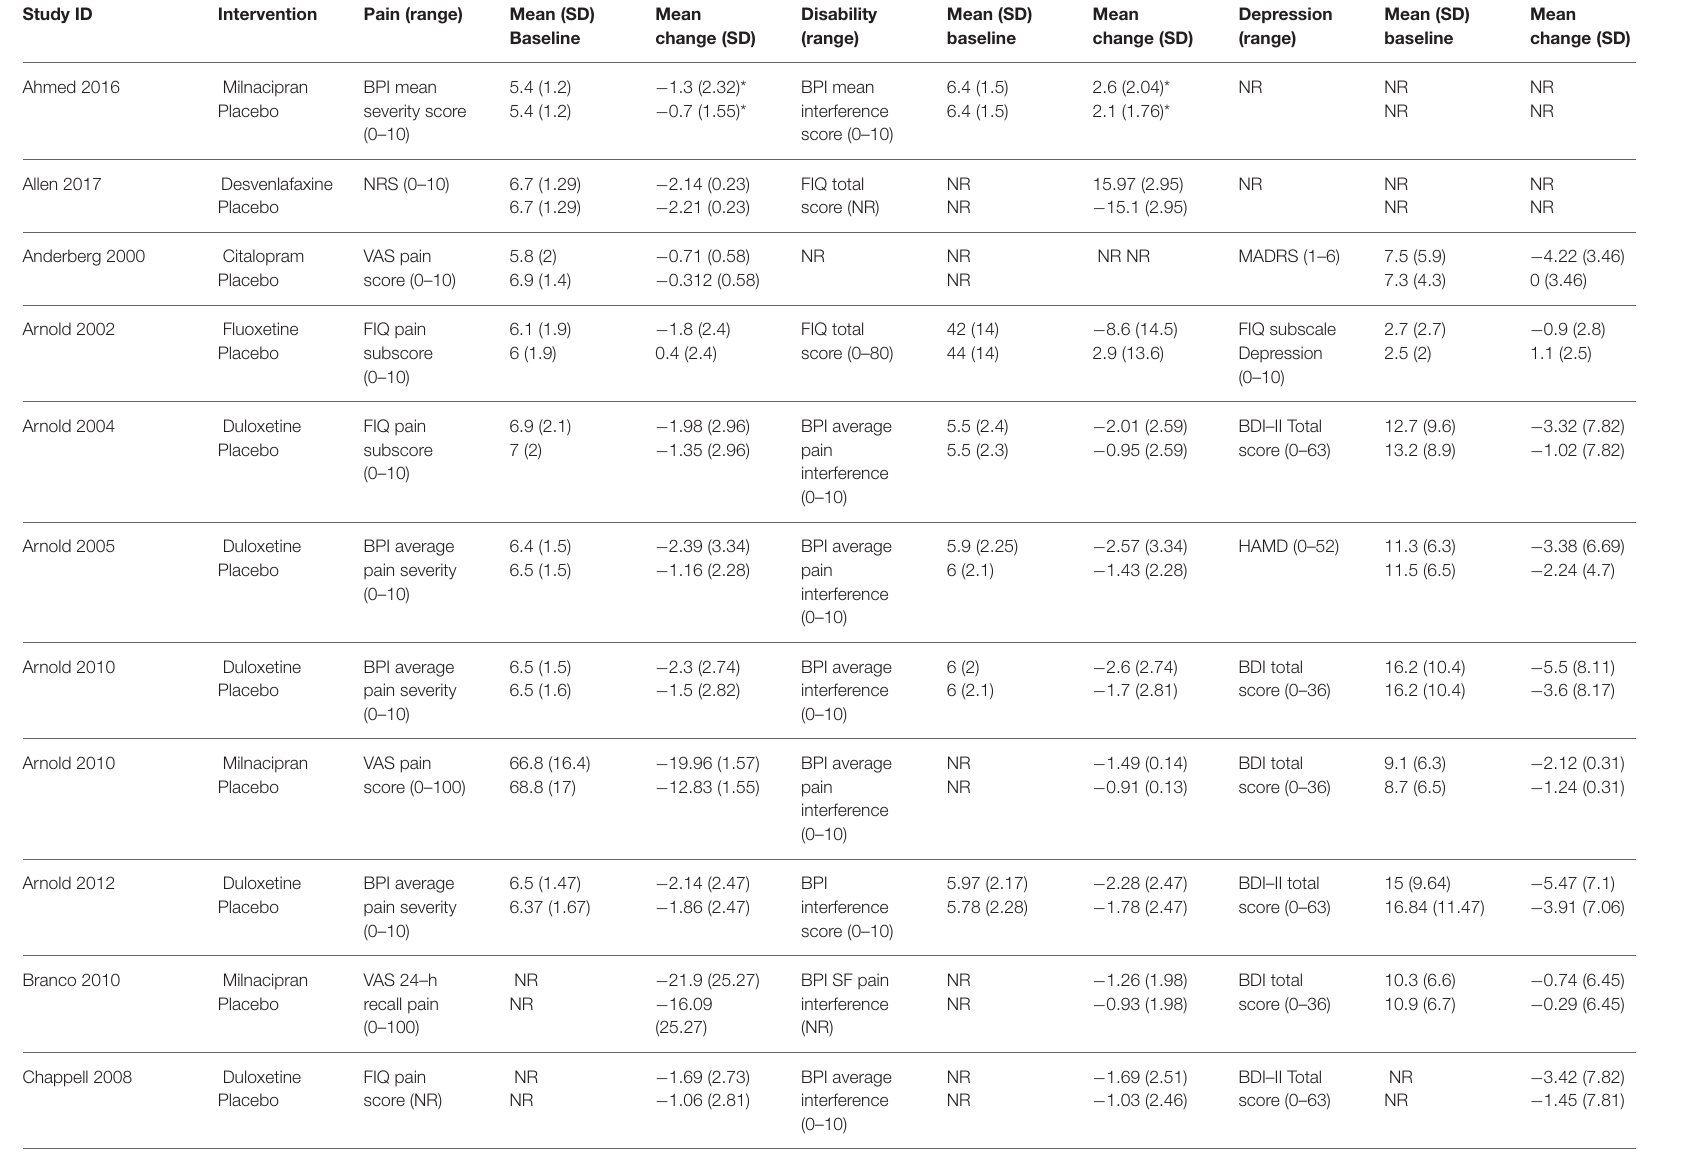
TABLE 2 | Measurements for all outcomes across included